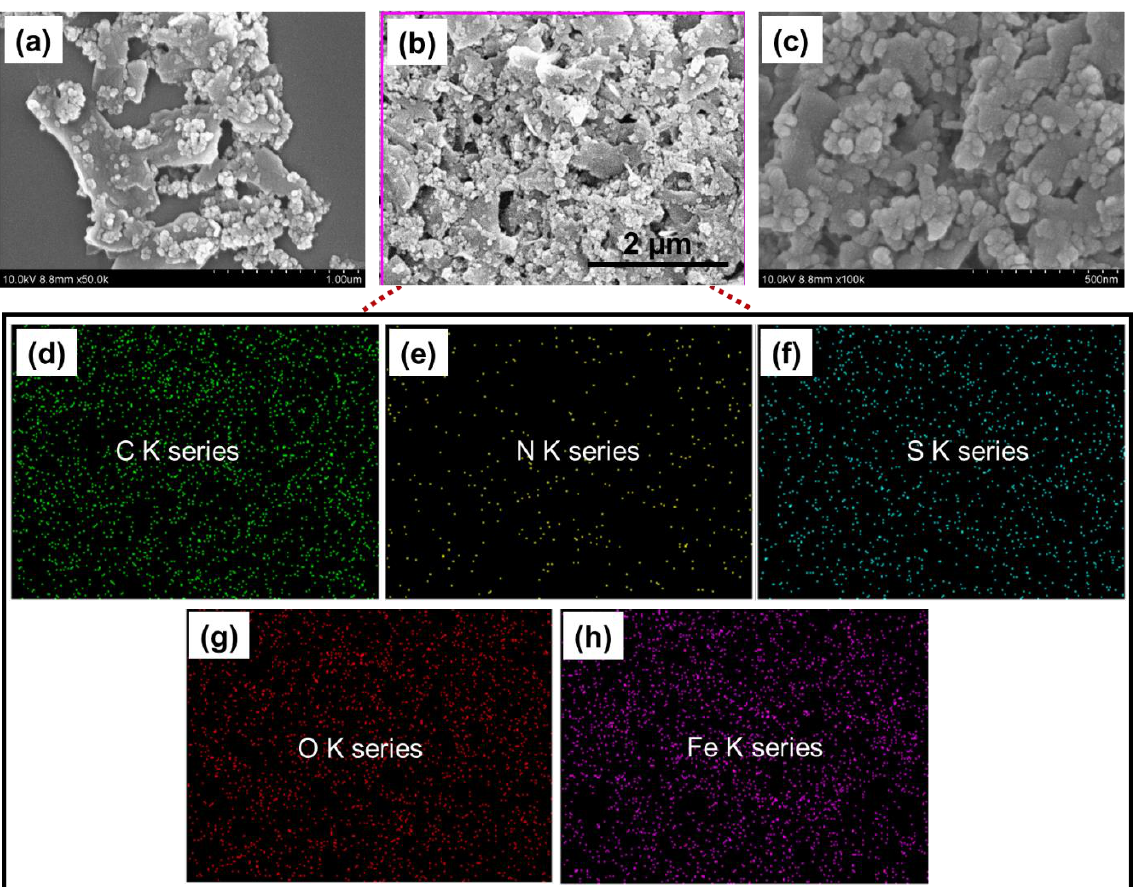
Figure 3. FESEM images of GPSBI ( a – c ). Elemental mapping of GPSBI C K series ( d ), N K series ( e ), S K series ( f ), O K series ( g ), and Fe K series ( h ).